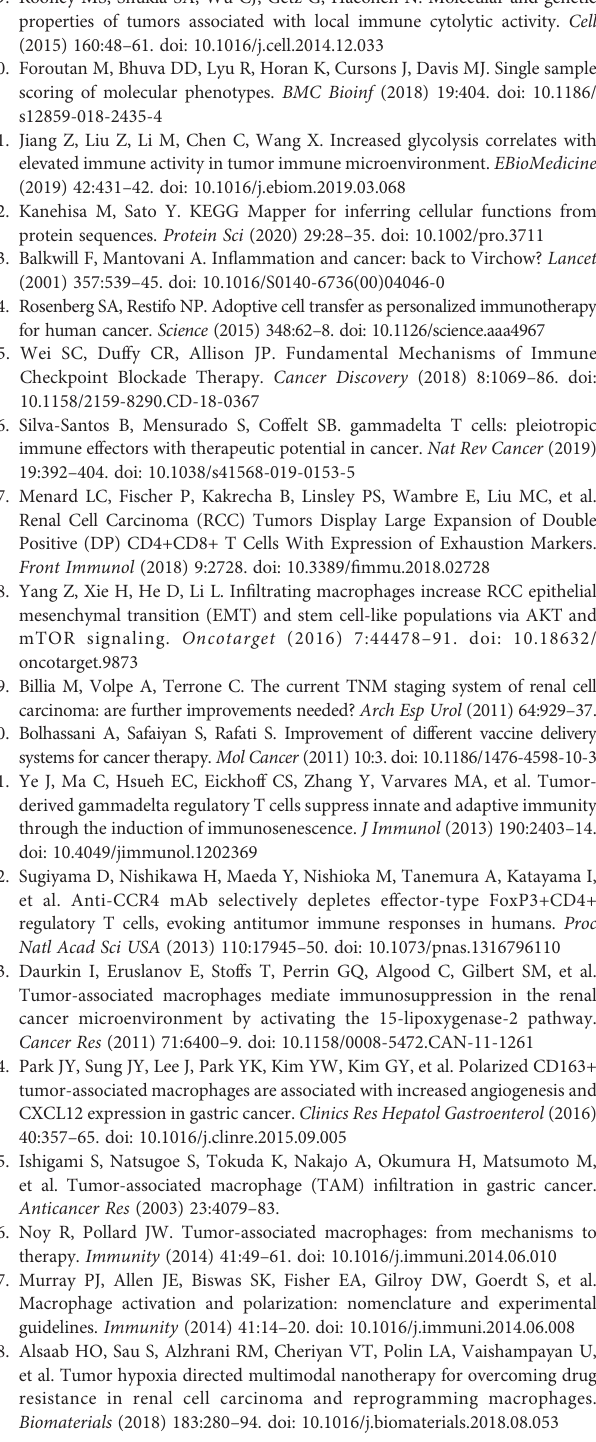
Supplementary Figure 9 | Validation clinical characteristics of the TIICs in GSE40435. Supplementary Figure 10 | Waterfall map depicts the top15 SNP in